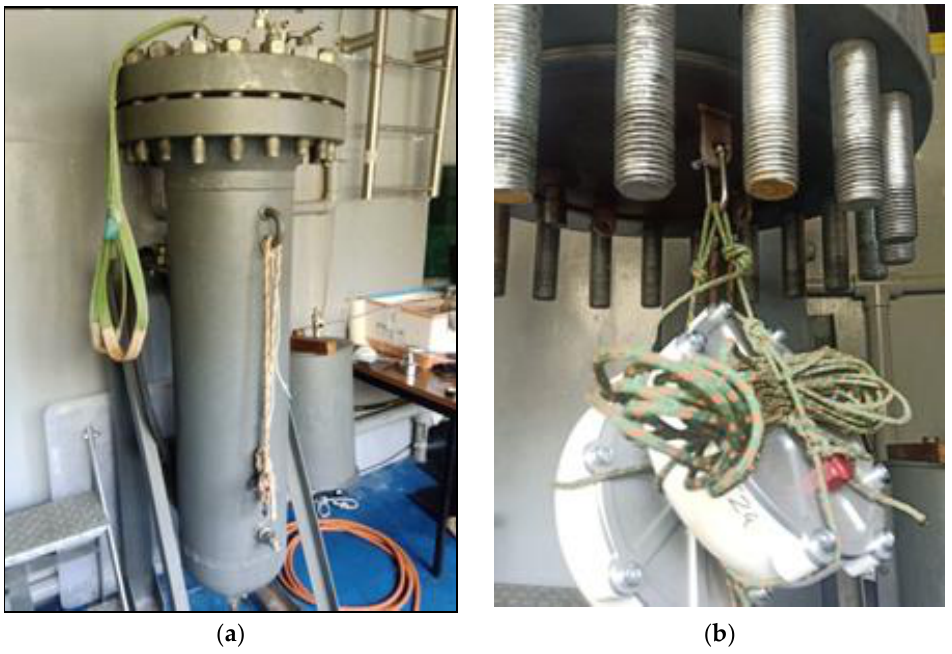
Figure 14. Pressure chamber at CRAS laboratory ( a ) and WCH housings held by a rope before sub- mergence ( b ). submergence ( b